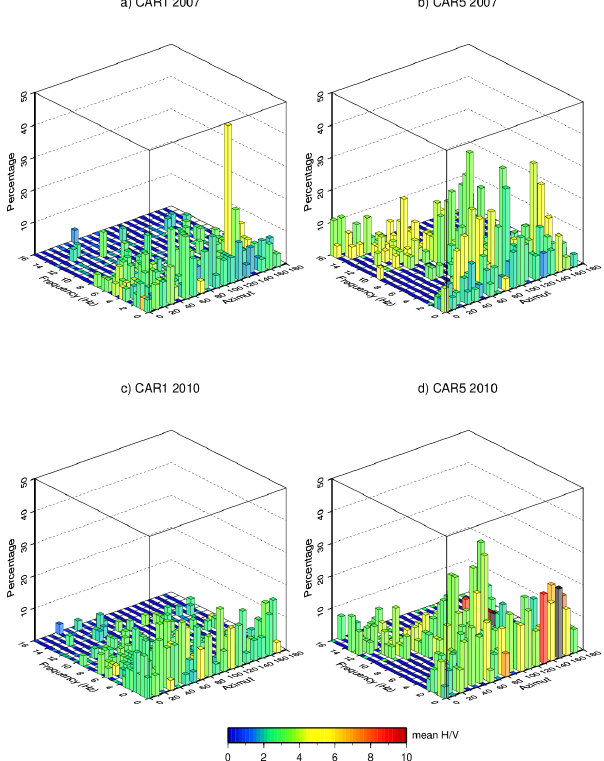
Fig. 4 - Histograms of DHVPOR (Directional H/V Peak Occurrence Rate) values obtained for noise measurements carried out at site CAR2 in 2007 with the tromograph (a), in 2010 with the broad-band sensor (b) and in 2011 using simultaneously the tromograph (c) and the broad-band sensor (d). The colours represent, according to the reported scale, the average of H/V peak values in recording time windows along different azimuths and within 0.5 Hz frequency intervals.